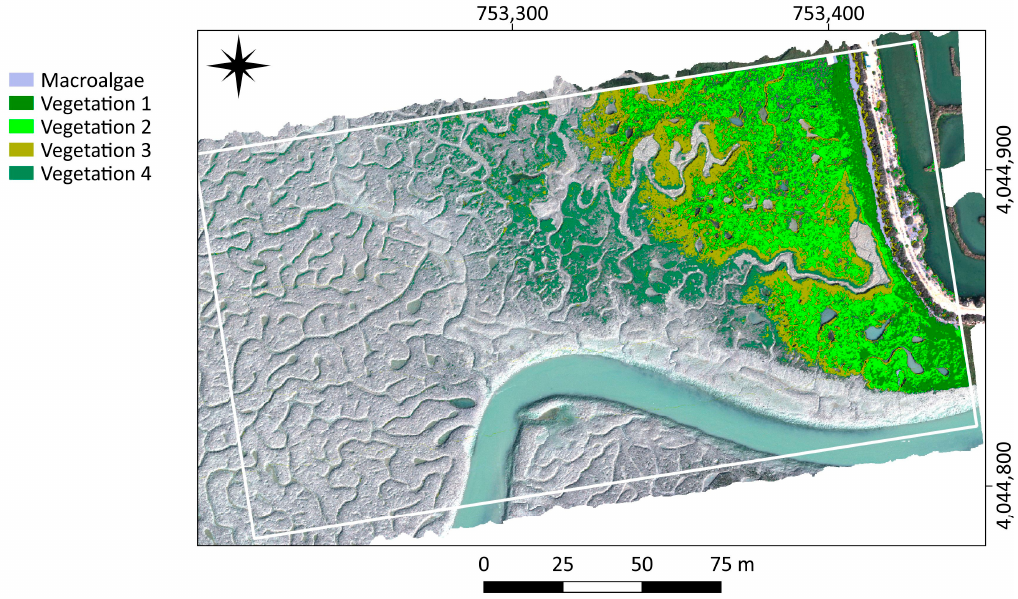
Figure 4. Salt marsh vegetation distribution according to the SVM classification. The white line defines the boundaries of the surveyed area, corresponding to 4.8 ha. The macroalgae class is debris deposited in the uppermost zone of the salt marsh representing less than 3% of the vegetated space. Vegetation 1 and vegetation 2 are distributed along the medium marsh horizon, vegetation 3 corresponds to the transitional zone, and vegetation 4 spreads along the low marsh horizon. The classification is superposed on the orthomosaic obtained by the hyperspectral survey displayed in true colour combination.